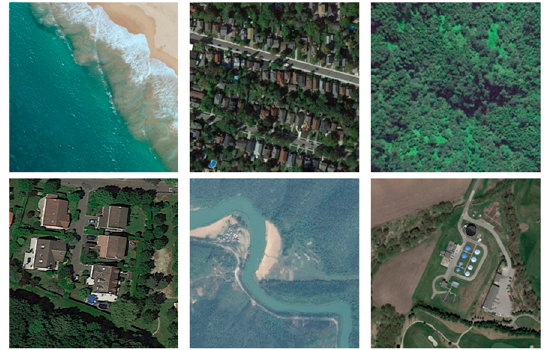
Figure 12. A sample diagram of the AID dataset.